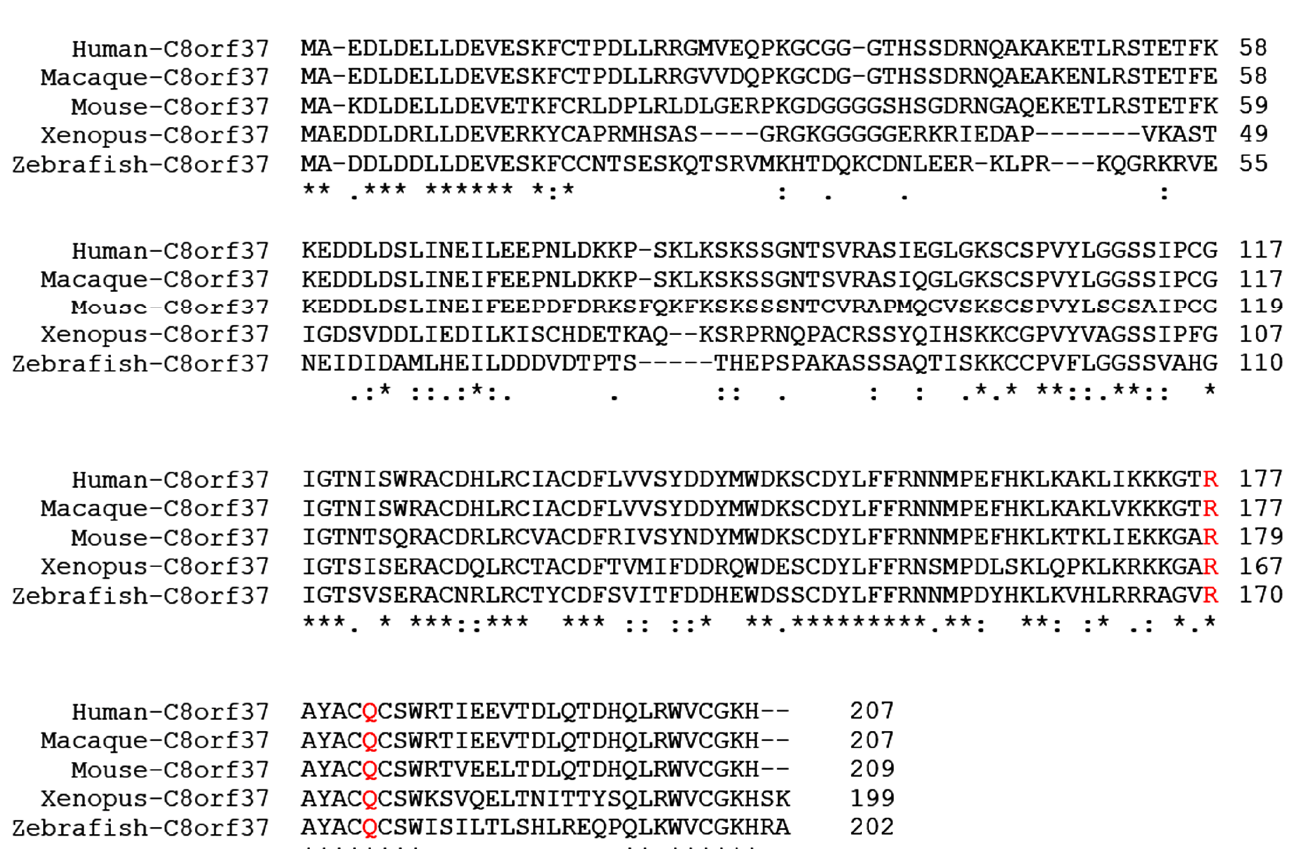
Figure 7. Alignment of C8orf37 homologs. Alignment of human, macaque, mouse, Xenopus laevis , and zebrafish homologs was performed via CLUSTAL O (1.2.4). Amino acid residues 1–17 and 100–207 of C8orf37 are highly conserved between human, macaque, mouse, Xenopus and zebrafish. The C8orf37 (R177W) and C8orf37 (Q182R) mutations are indicated in red. Fully conserved residues are denoted by an asterisk (*).